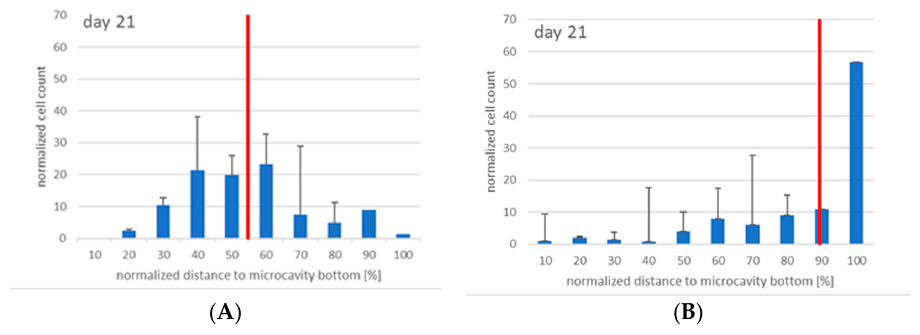
Figure 10. Migratory behaviour of CD34 + ( A ) and CD38 + ( B ) cells at day 1, 3 7, 14, and 21 (from top to bottom), n = 3, * = p < 0.05.